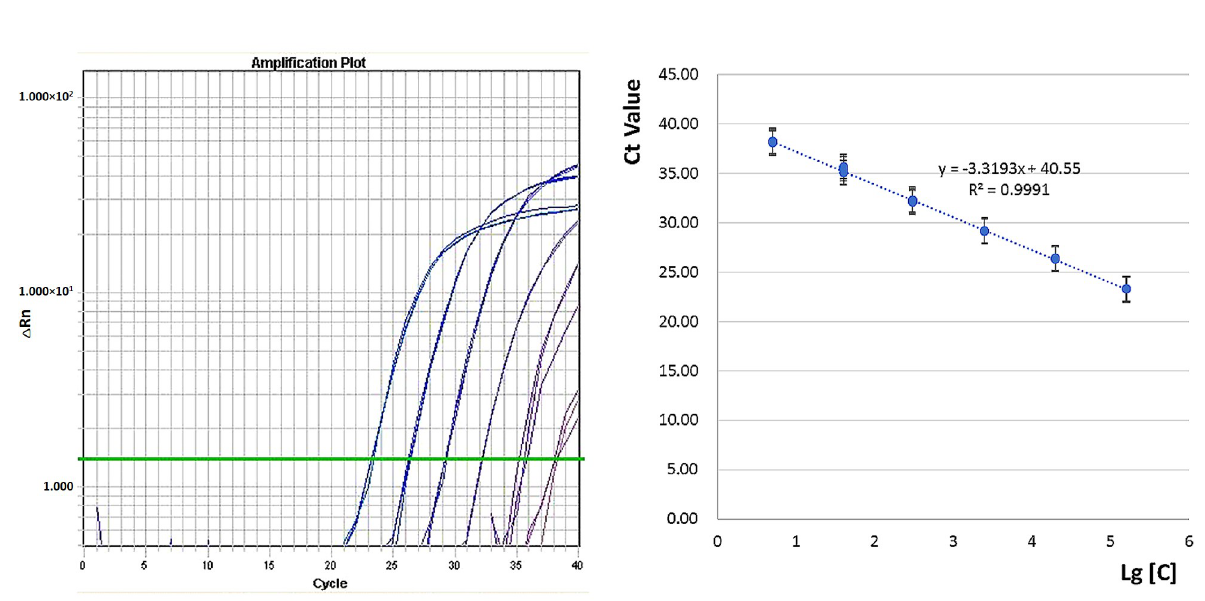
Figure 3. Standard curve construction and dynamic range determination of event-specific real-time PCR